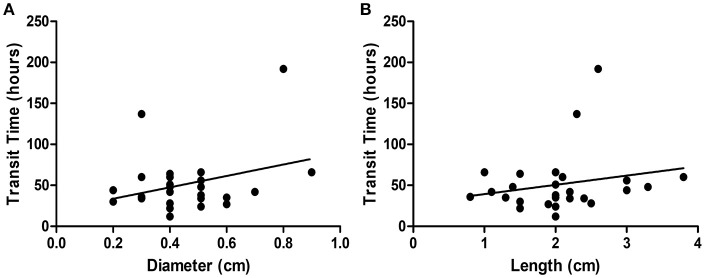
Linear regression analysis of the correlation between size [diameter (A); length (B)] and transit time in irregularly foreign bodies.